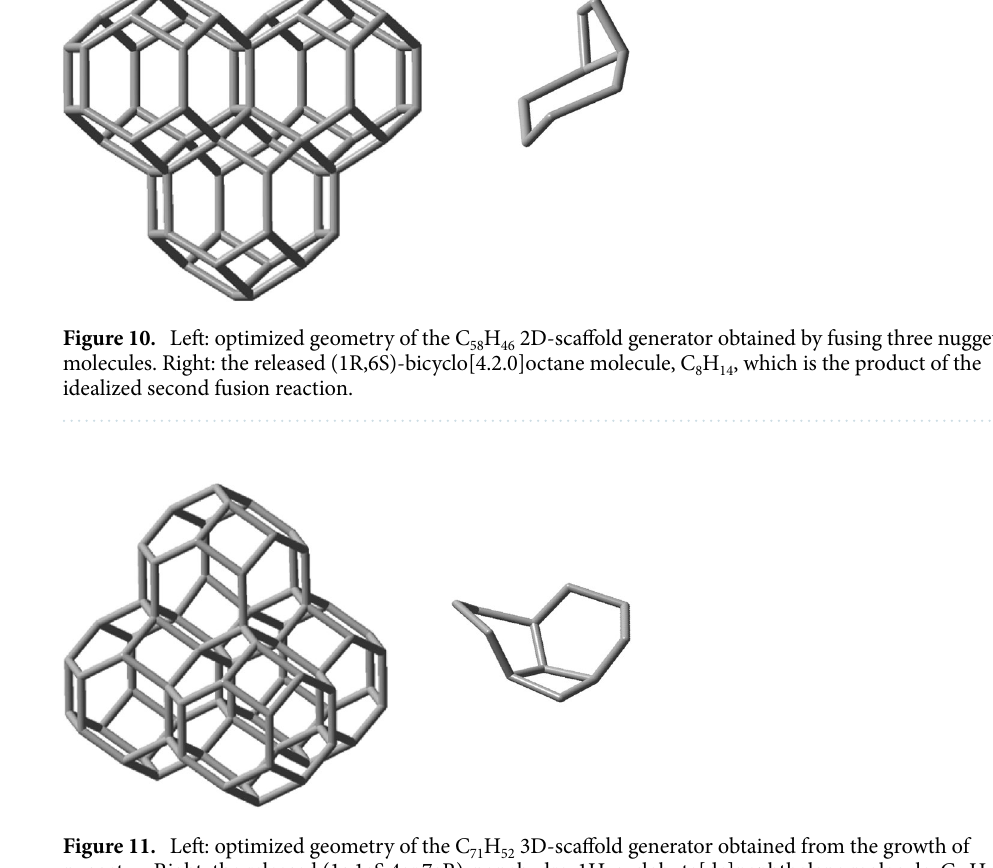
Figure 11. Left: optimized geometry of the C 71 H 52 3D-scaffold generator obtained from the growth of nugget 24a . Right: the released (1s,1aS,4ar,7aR)-nonahydro-1H-cyclobuta[de]naphthalene molecule, C 11 H 18 , which is the product of the idealized third fusion